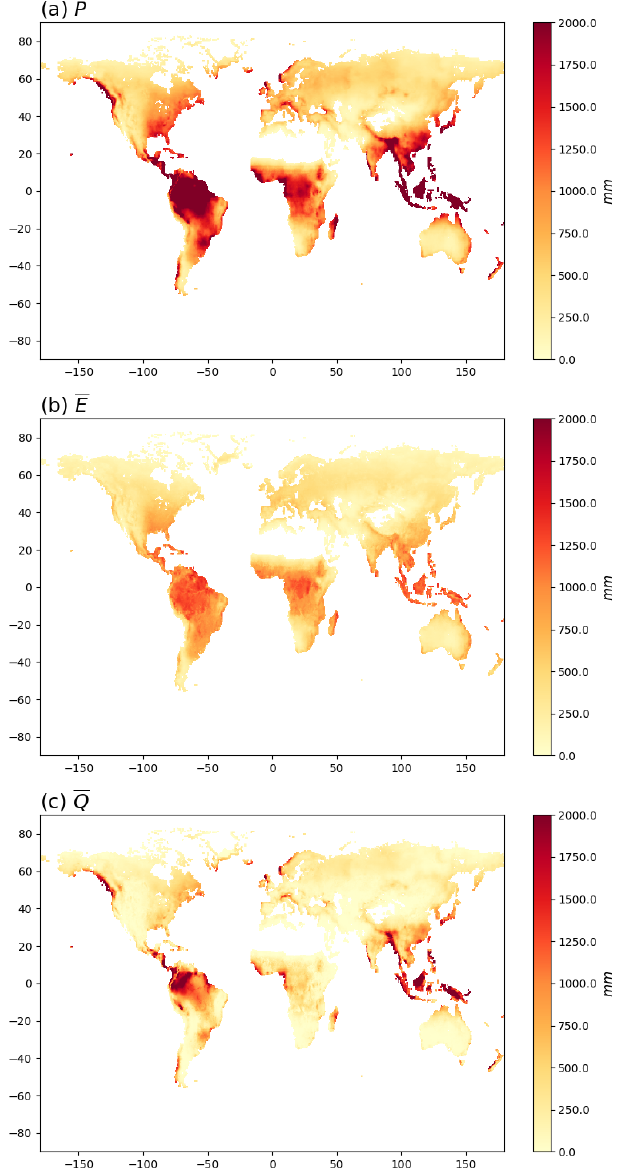
Figure 1. Mean annual (1984–2010) (a) P , (b) E and (c) Q . Note that the mean annual (cid:49)S in the CDR database is zero by construc- tion and is not